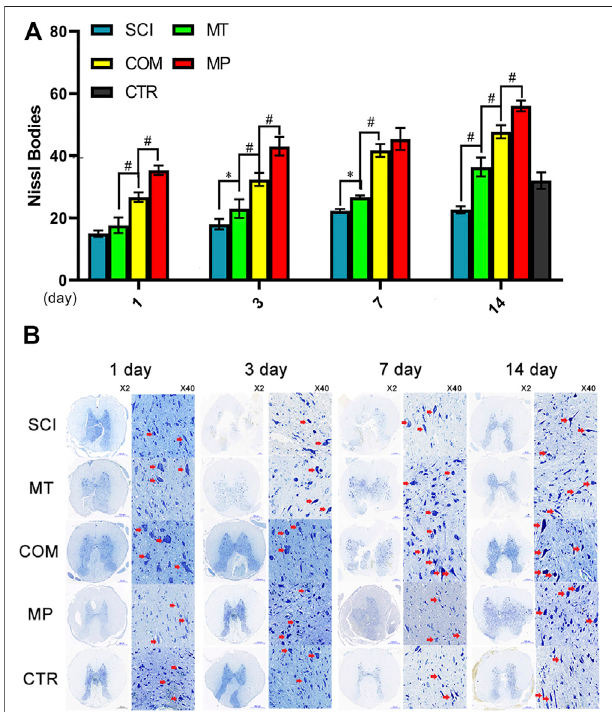
FIGURE 1 | The Nissl body number in neuronal samples from the treatment groups. (A) : The number of Nissl bodies were quanti fi ed on the 1st, 3rd, 7th, and 14th day in neuronal samples taken from control rats (CTR, The average of the 4 sampling time points), rats with SCI (SCI), rats treated with melatonin (MT), methylprednisolone (MP), or a combination of MT with a low dose of MP (COM). (B) : Representative images of neuronal samples stained for the presence of Nissl bodies with crystal violet. The red arrow indicates the intact Nissl bodies. Error bars represent the standard deviation. * p < 0.05, # p < 0.01 ( n (cid:1)